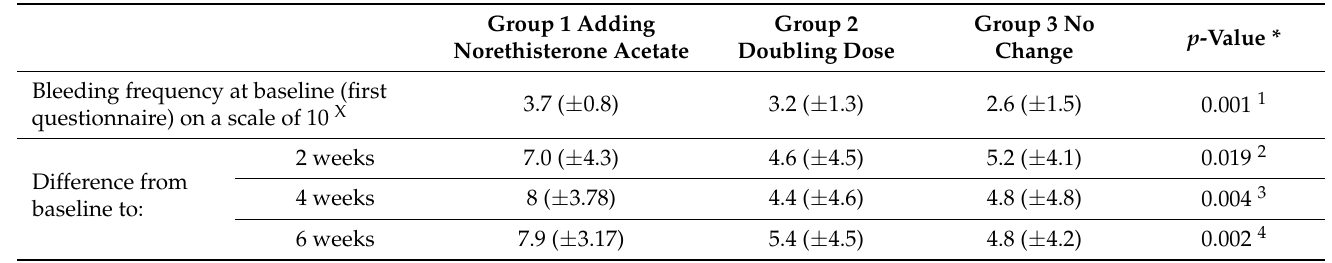
Table 2. Comparison of bleeding frequency (mean ± SD).